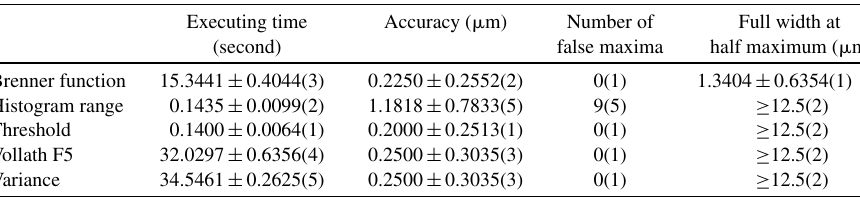
Results of the evaluation of autofocus functions for blood